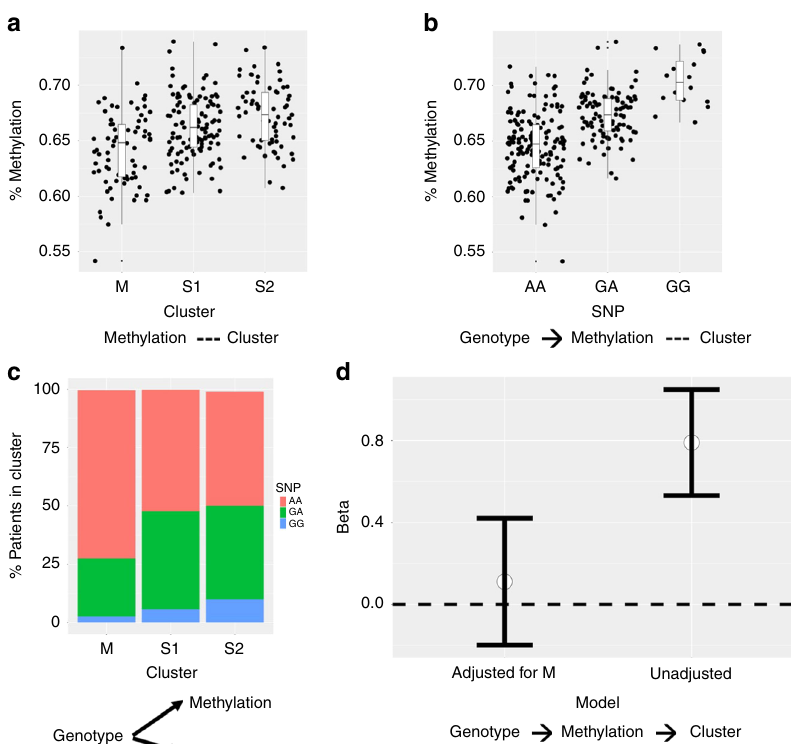
Fig. 5 Identi fi cation of candidate cluster-associated cg07259759 ( USP35 ) that mediates genetic association of rs7104222 ( GAB2 ) with clusters. Association of DNA methylation of cg07259759 and cluster ( a ) or genotype of rs7104222 ( b ). c Association between genotype rs7104222 and clusters. d Beta coef fi cient represents the dependence of cluster on genotype with or without adjusting for methylation. Error bars represent the 95% con fi dence interval for beta coef fi cient estimate. After adjusting for methylation, the observed dependence reduces toward